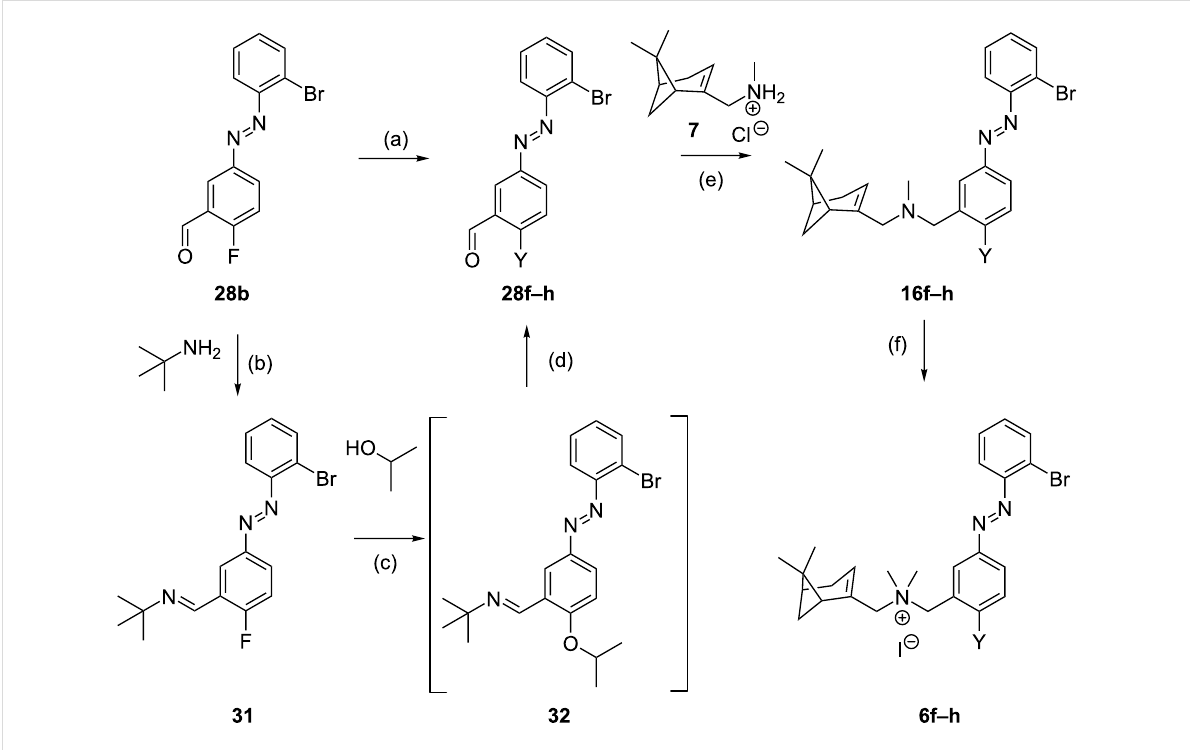
Table 3: Structure and results of photochemical and binding characterization of compounds 3e , 4d , 6b and 6d–i .